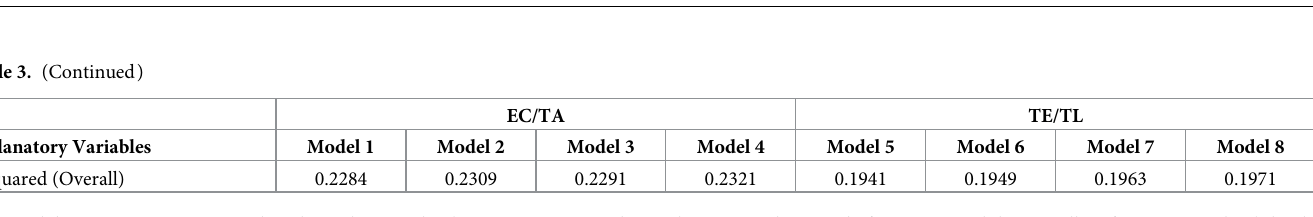
The panel data regressions estimate the relation between banking competition and capital ratio over the period of 2005–2018 while controlling for important bank-level and macroeconomic characteristics. The sample includes 225 banks in 18 countries in the MENA region. Banks included in the sample are conventional banks (162) and Islamic banks (63). As a measure of bank capitalization level we use the Total eligible capital to total assets (EC/TA) and Total equity to total liability (TE/TL). Bank- level characteristics and capital ratio are computed as of year t-1 . All the regressions control for year and country fixed effects. � , �� , and ��� indicate statistical significance at the 10%, 5%, and 1% level, respectively. The values in parenthesis represent ’p-value’. Capital adequacy ratio, market competition indicators, bank-level characteristics, institution, ownership and macroeconomic variables are described in S1